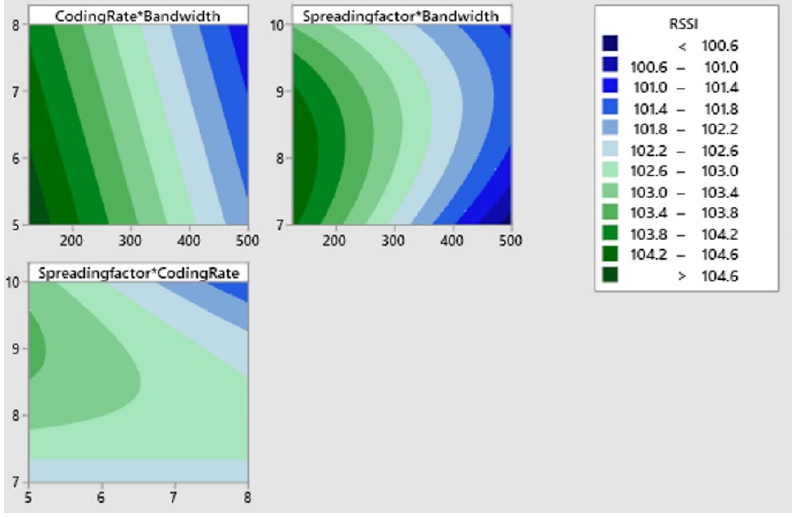
Figure 11. Contour graphs for settings evaluated in Experiment 3.